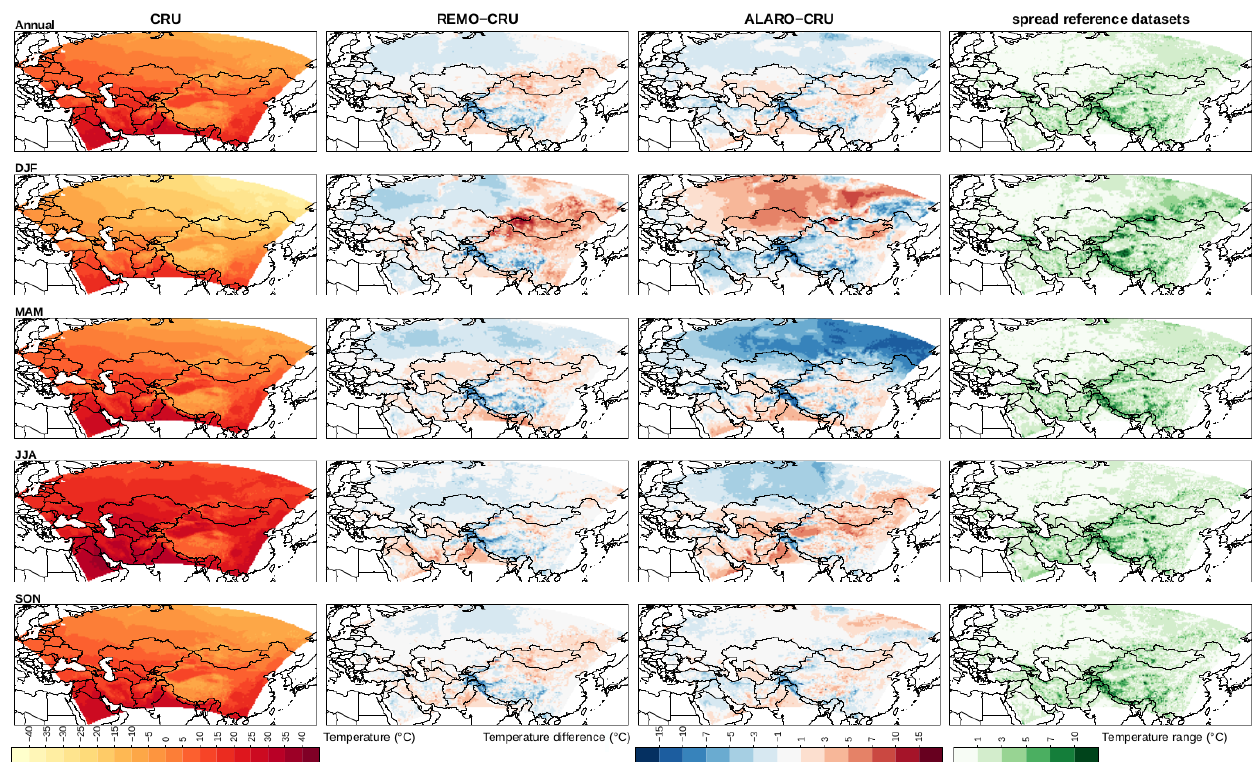
Figure 3. Left column: mean air temperature ( ◦ C) at 2m height over the CAS-CORDEX domain based on the observational CRU dataset for the 1980–2017 period on an annual level and for winter (DJF), spring (MAM), summer (JJA), and autumn (SON). Middle columns: difference in mean temperature between models and CRU. Right column: the range in mean temperature ( ◦ C) between the different reference datasets (CRU, MW, and